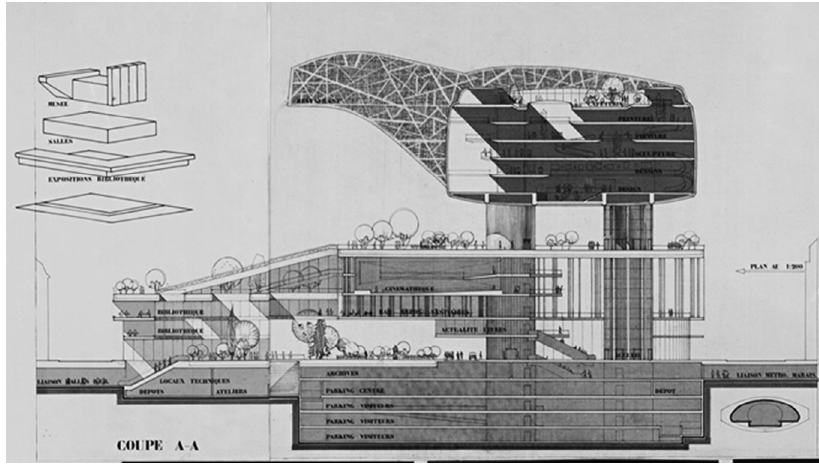
Figure 5. Bergerioux, projet 006. Section A-A.